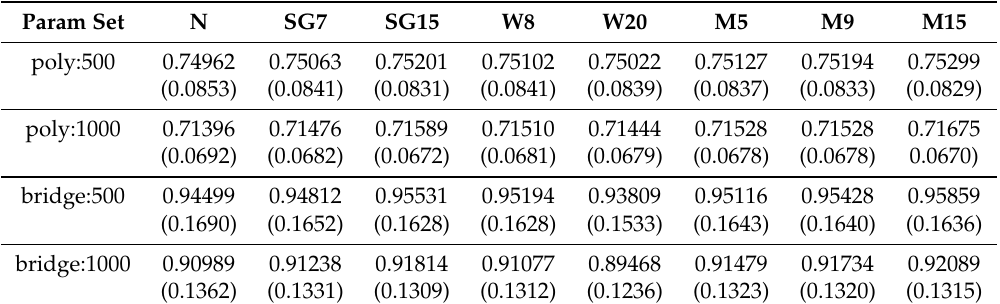
Table 5. The α values averaged over all time series for all parameter sets. Standard deviations are placed in brackets.